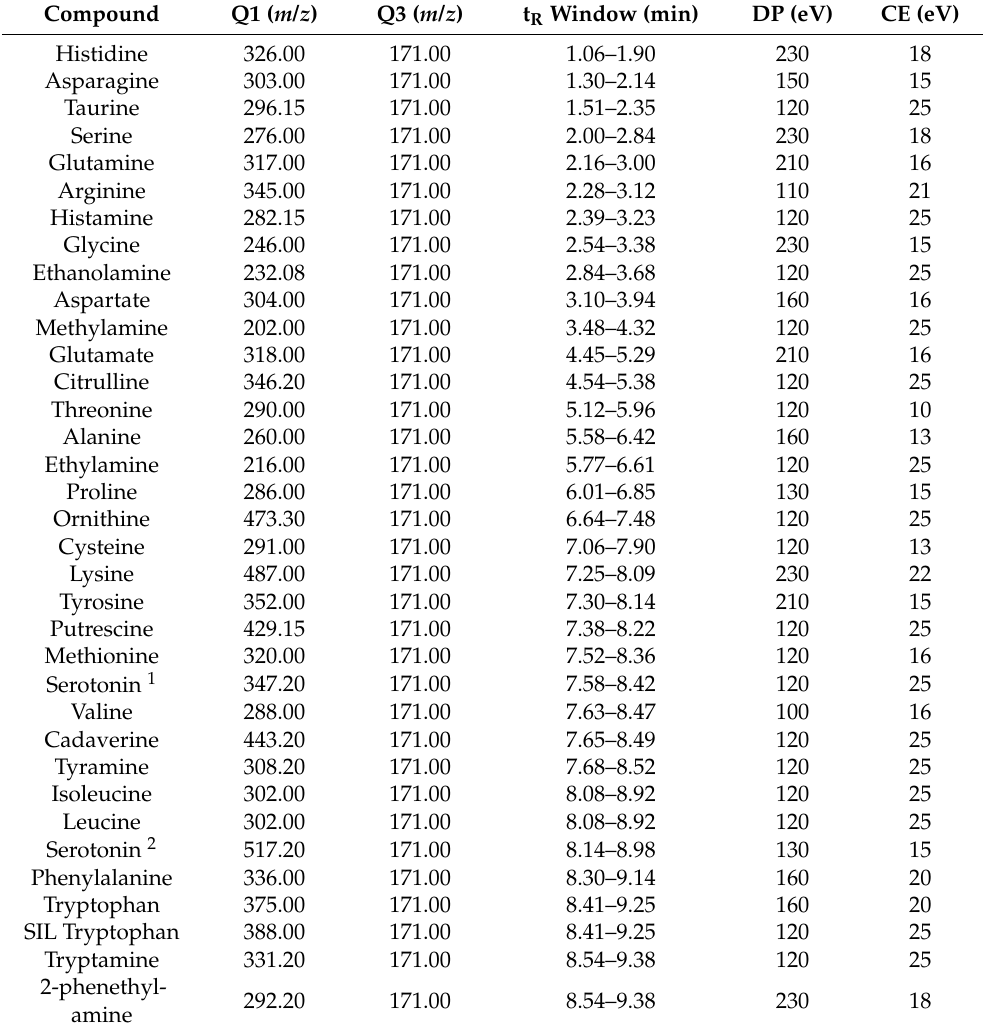
Table 5. Parameters of the Selected Reaction Monitoring (SRM) analysis. Q1 m / z : Parent ion, Q3 m / z : Fragment ion, t R window: Retention time window in minutes, DP: Declustering potential in